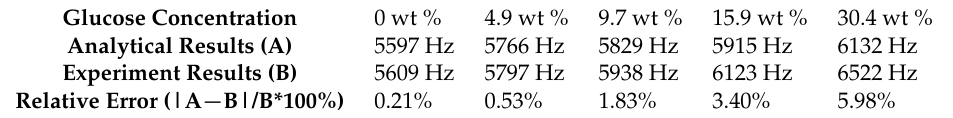
Table 1. Resonant frequencies obtained by analytical and experimental approaches.